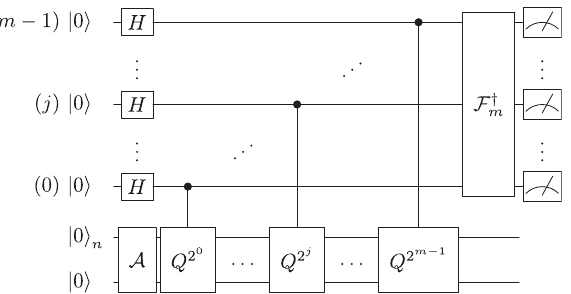
Fig. 1 Canonical QAE. Circuit with m ancilla qubits and n + 1 state